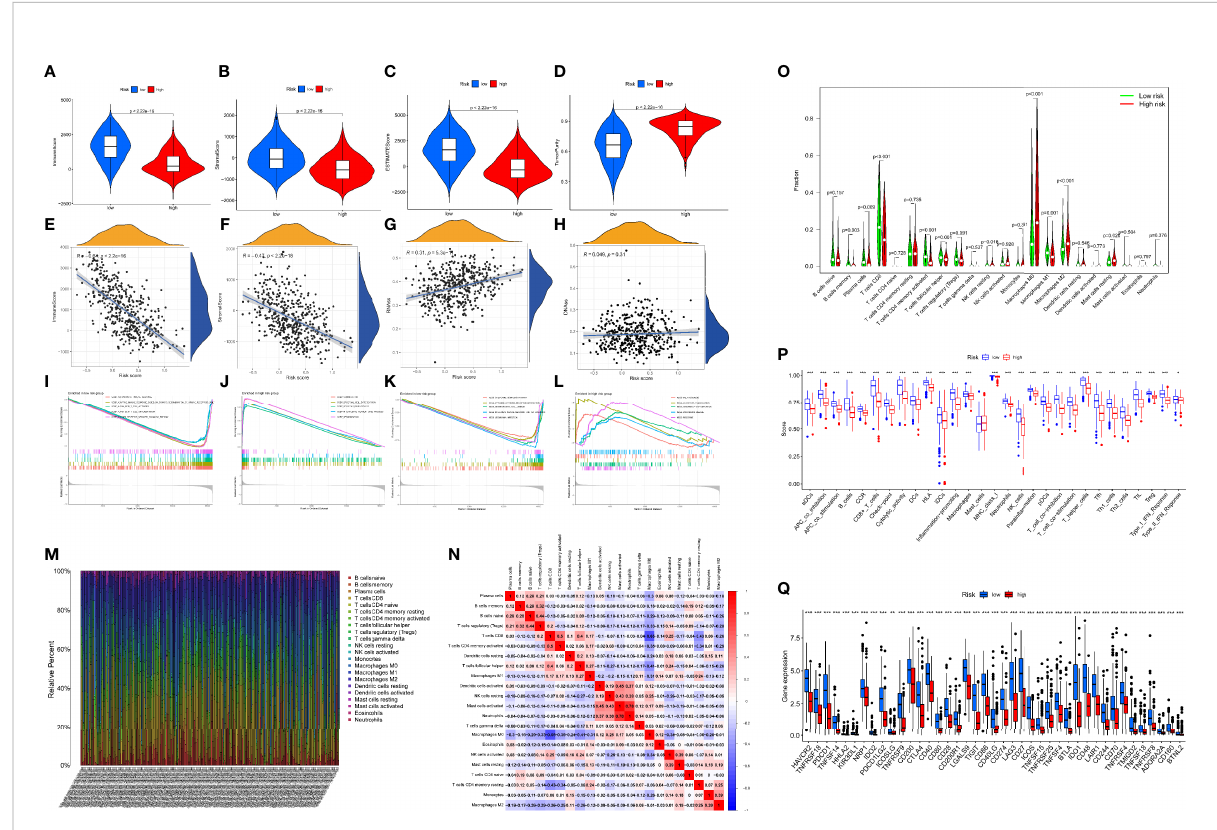
FIGURE 6 GSEA of SKCM patients premised on the DRRGs prognostic signature. (A – D) The expression differences of immune score, stromal score, ESTIMATE score, and tumor purity in high- vs. low-risk cohort; (E – H) Spearman correlation analysis of risk score with immune score, stromal score, RNAss, and DNAss; (I – L) GSEA outcomes illustrated substantial enrichment of immune-associated biological mechanism in the low-risk patients; (M) A Barplot of the 22 immune fractions designated by dissimilar colors in each SKCM sample; (N) Correlation heatmap of the ratio of TIICs; (O) Wilcoxon test of 22 immune fractions in high- vs. low-risk cohort; (P) Link between risk score and immune cell in fi ltration and related roles through the ssGSEA analysis. The score denotes the immune score, with elevated scores signifying a deeper extent of immune cell in fi ltration; (Q) ICB molecules expressed differently between high- and low-risk groups; (ns, not signi fi cant, *P < 0.05, **P < 0.01, and ***P <